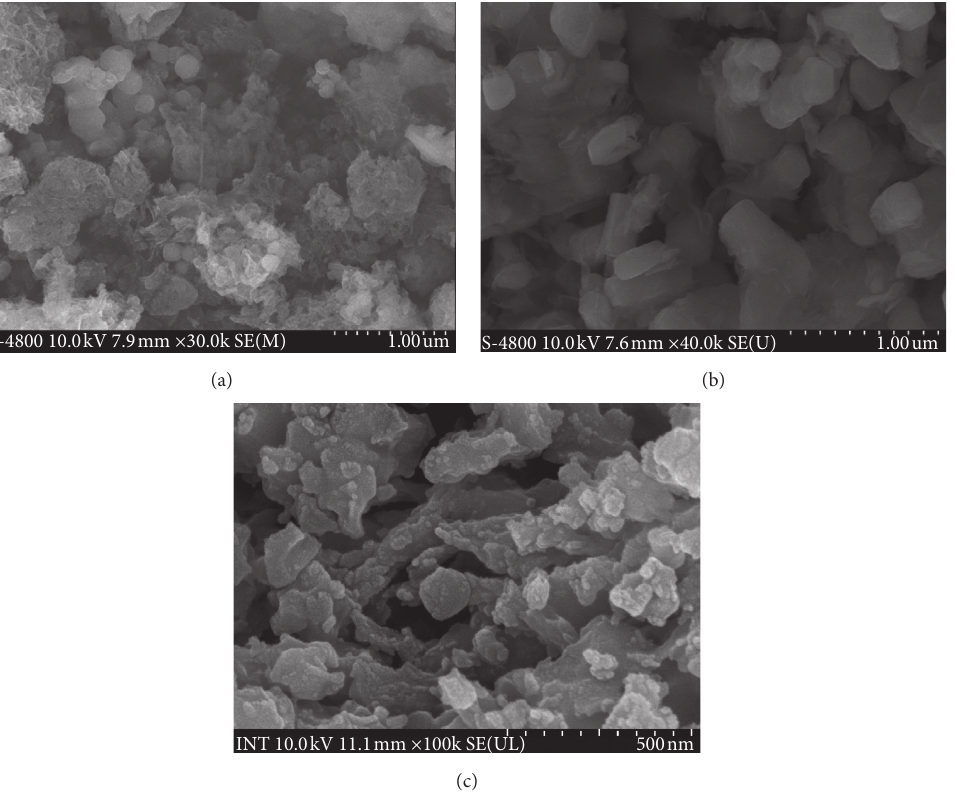
Figure 3: SEM images of (a) Ni-TiO